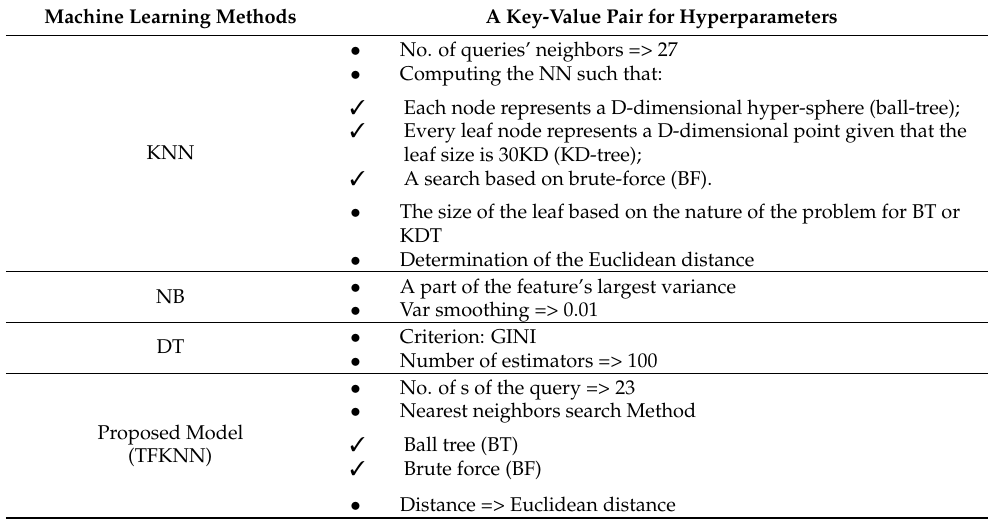
Table 6. Key-value pair for hyperparameters of different ML approaches used by the grid-search. Machine Learning